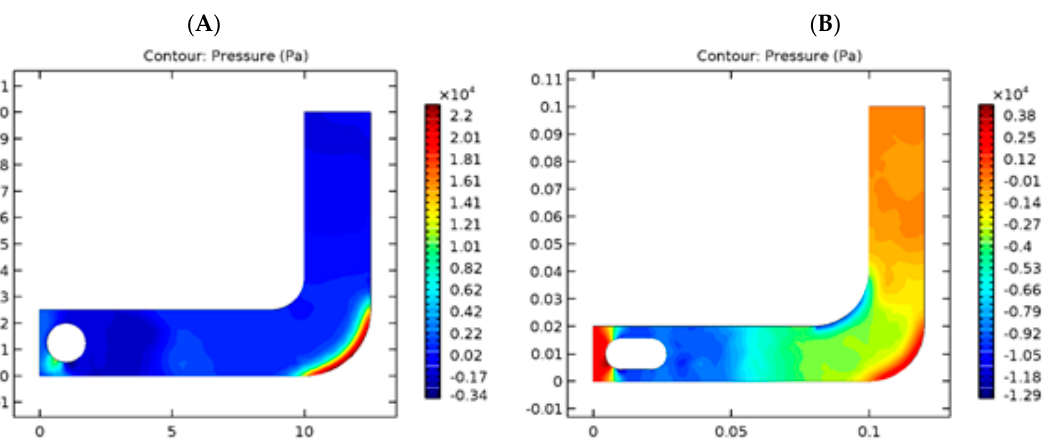
Figure 3. Comparison of pressure for spherical ( A ) and capsule ( B ) geometries in the GI tract.